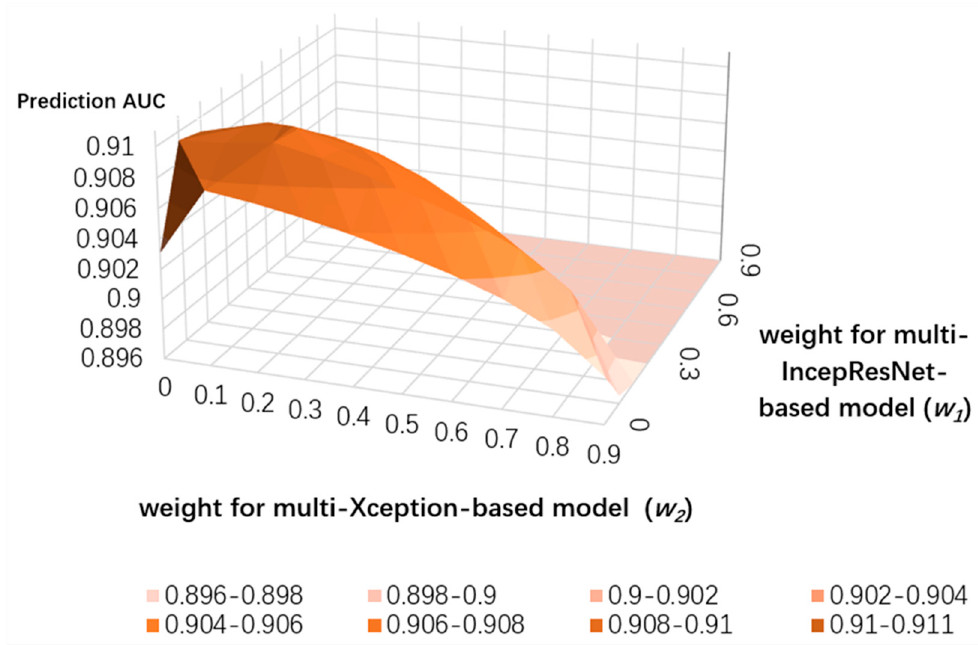
Figure 5. Grid search for optimized weight distribution on ATP-388 over five-fold cross validation.